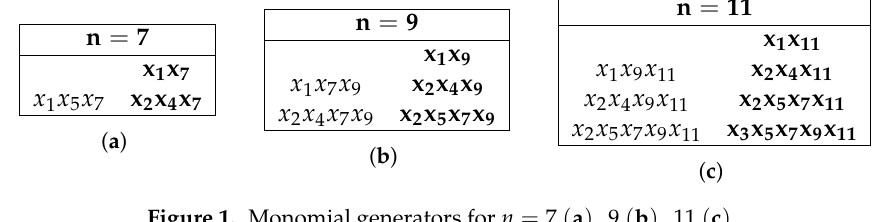
Figure 1. Monomial generators for n = 7 ( a ) , 9 ( b ) , 11 ( c )